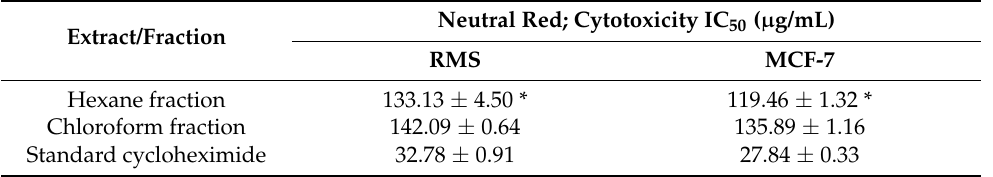
Table 4. Cytotoxic activity (IC 50 ) of human RMS and MCF-7 cells treated with hexane and chloroform fractions of C. minima and the positive control, determined by neutral red